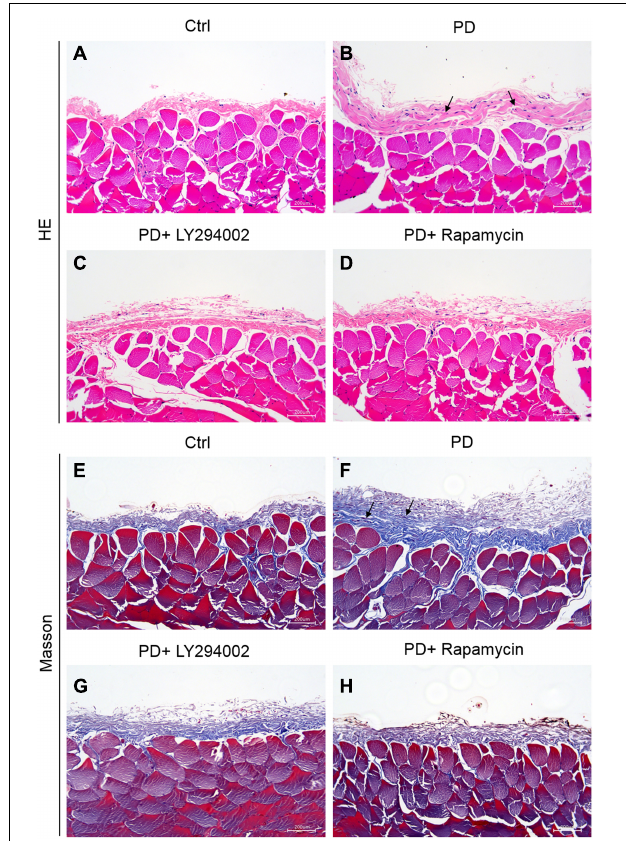
FIGURE 3 | Establishment of HG-induced peritoneal fibrosis in rats. (A–D) HE staining was used to analyse the peritoneal tissue in the control group, the HG peritoneal dialysate-induced group and PD rats treated with LY294002 or rapamycin. (E–H) Masson staining was used to analyse the peritoneal tissue in the control group, the HG peritoneal dialysate-induced group and PD rats treated with LY294002 or rapamycin. Bar = 200 µ m. The location indicated by the black arrow is collagen